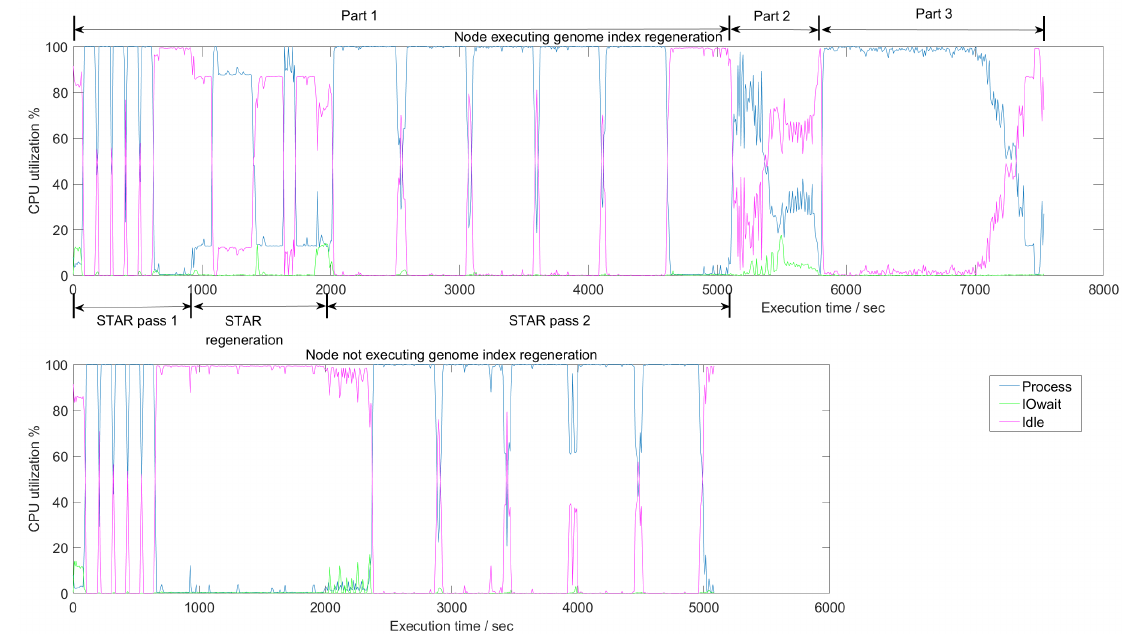
Figure 8. Average CPU utilization of the three different parts of SparkRA on a 16-node cluster. In Part 1, there are three steps: STAR pass 1, STAR index regeneration, and STAR pass 2. The top and bottom charts show utilization in a node with and without genome index regeneration, respectively. Parts 2 and 3 are not shown in the bottom chart, since they are identical to the top chart. Measurements are generated using the iostat profiler